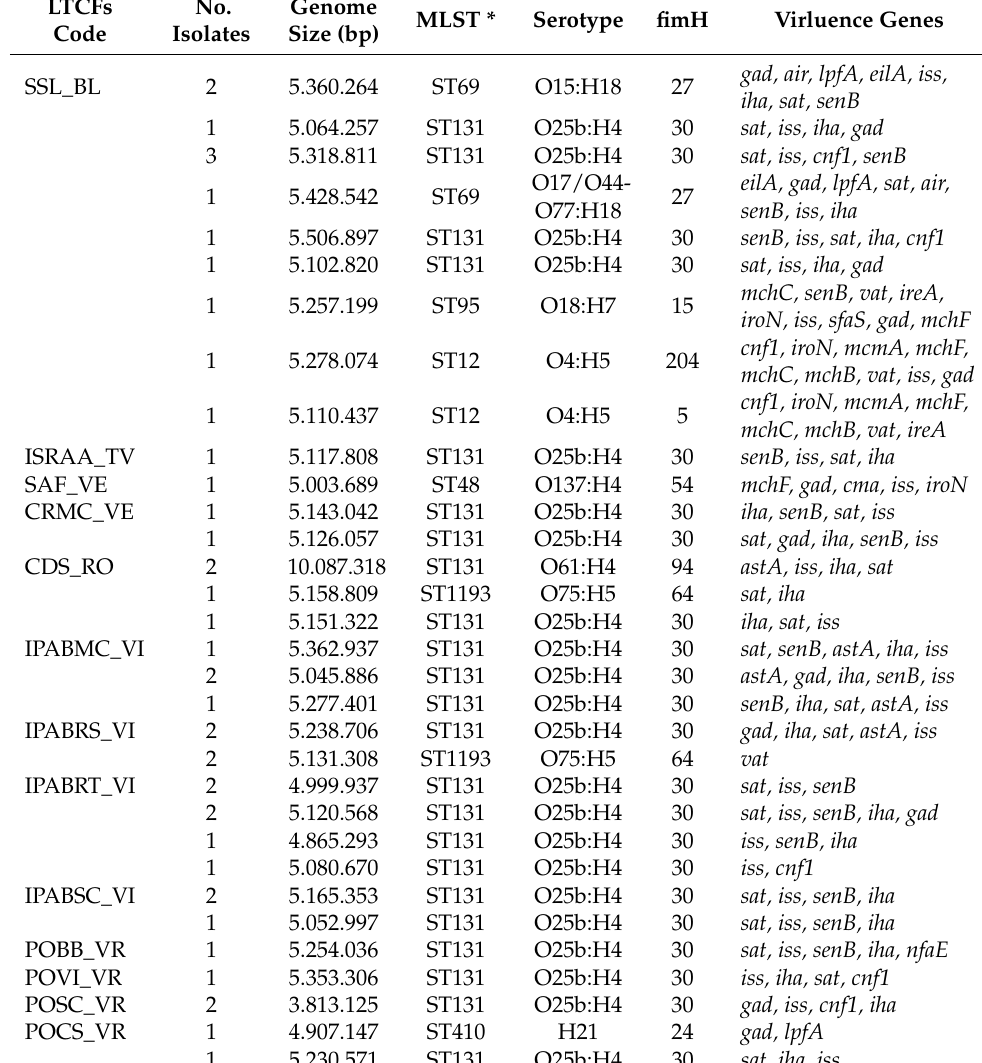
Table 1. Genome analysis of E. coli isolated from residents of 13 LTCFs (Northern Italian